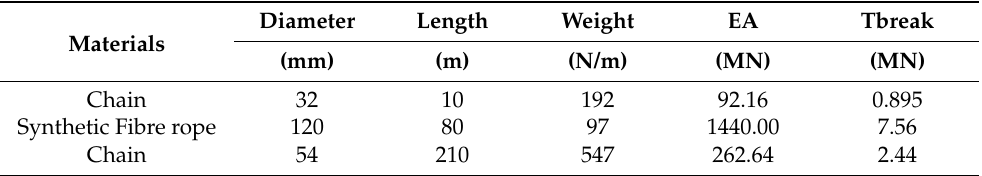
Table 5. Material property of cables for Case 2 (minimum diameter).